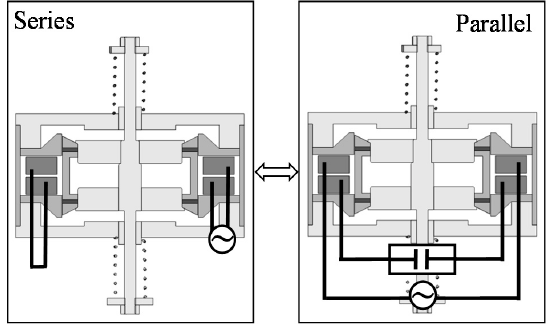
Figure 4. Connections of coils in proposed actuator.